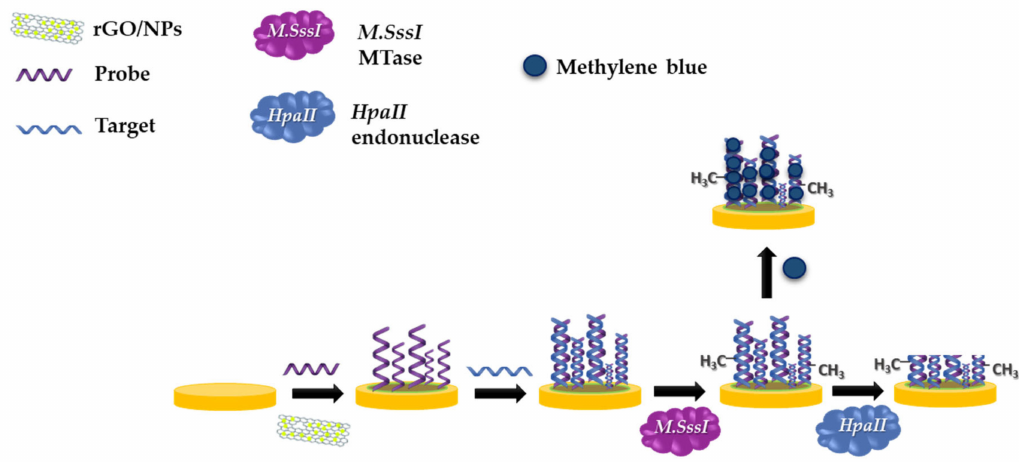
Figure 1. Schematic of biosensor development including each step of immobilization and treatment by enzymes.